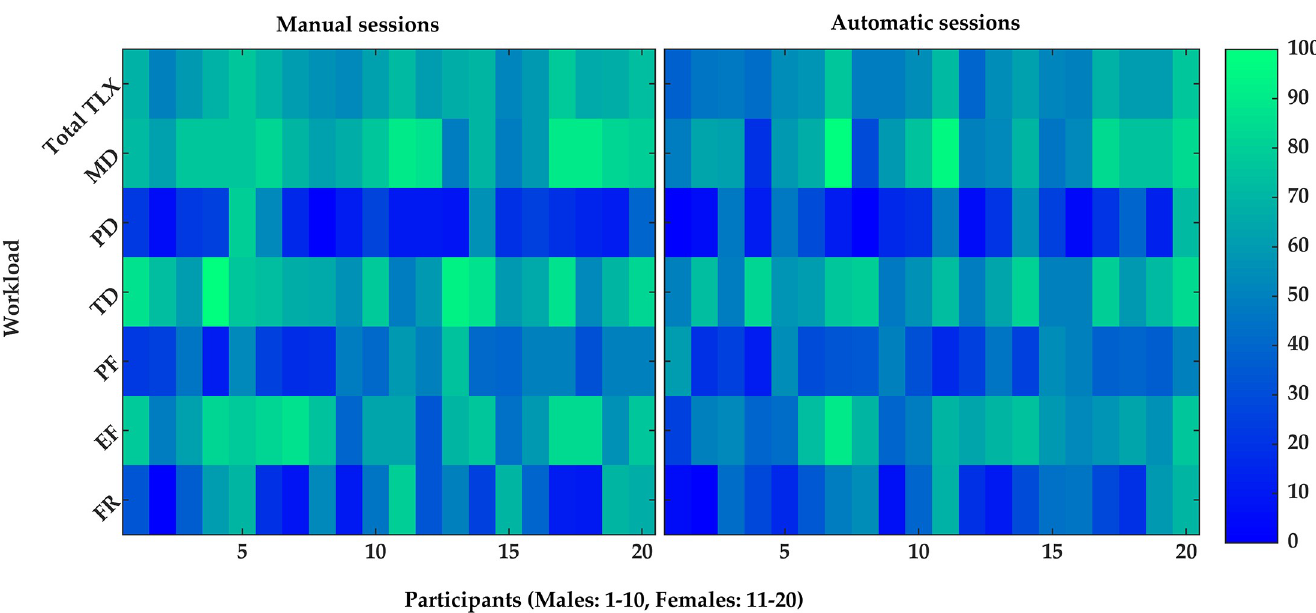
Fig 7. The obtained ratings of total task load index (TLX) and NASA-TLX subscales, i.e. Mental Demand (MD), Physical Demand (PD), Temporal Demand (TD), Performance (PF), Effort (EF), and Frustration (FR). The participants are separated by their sex on the x-axis to males (1–10) and females (11–20). The NASA-TLX scores are depicted separately for the automatic and manual sessions.